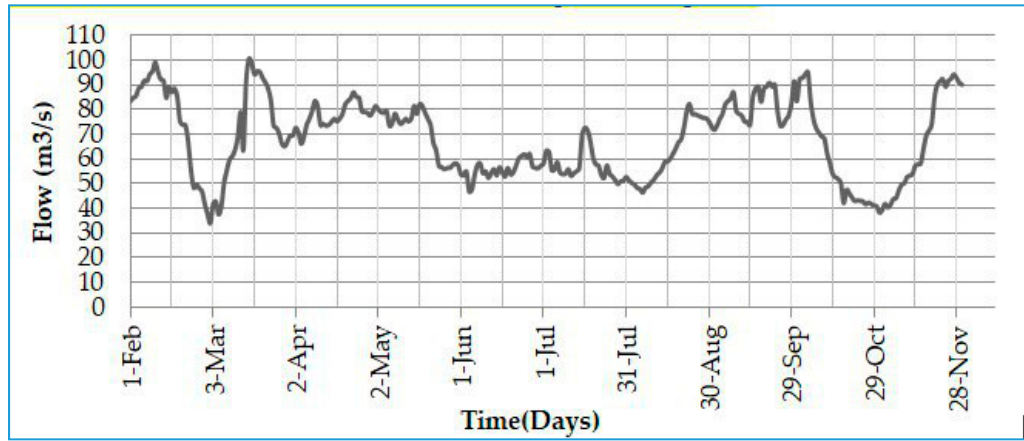
Figure 5. Daily discharges of the Tigris River for the year 2014 [25].